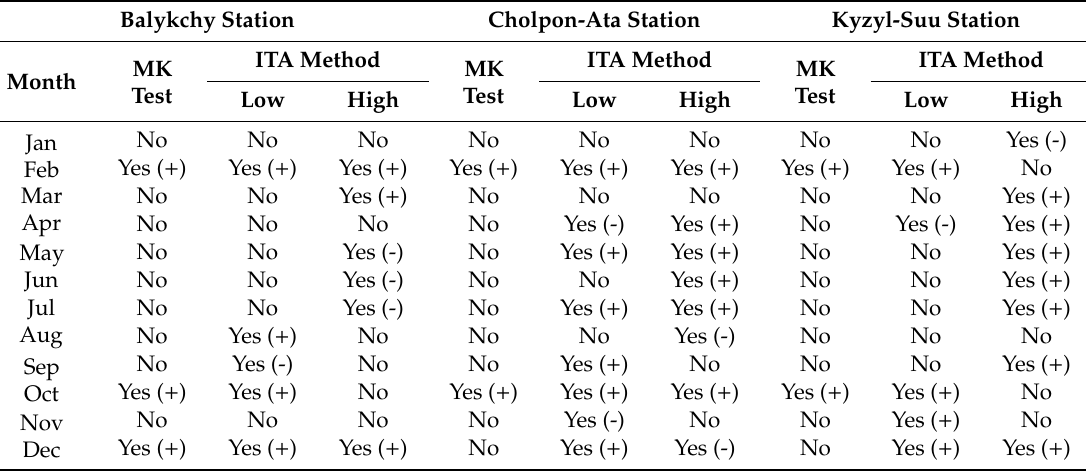
Table 3. A comparison of the Mann-Kendall trend test and the ITA method for analyzing the temporal precipitation dynamics in the Lake Issyk-Kul basin between 1951 and